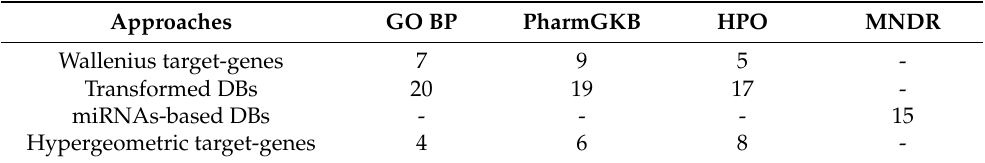
Table 1. Count of cardiac excitability associated terms in each type of analysis and annotation database in the top